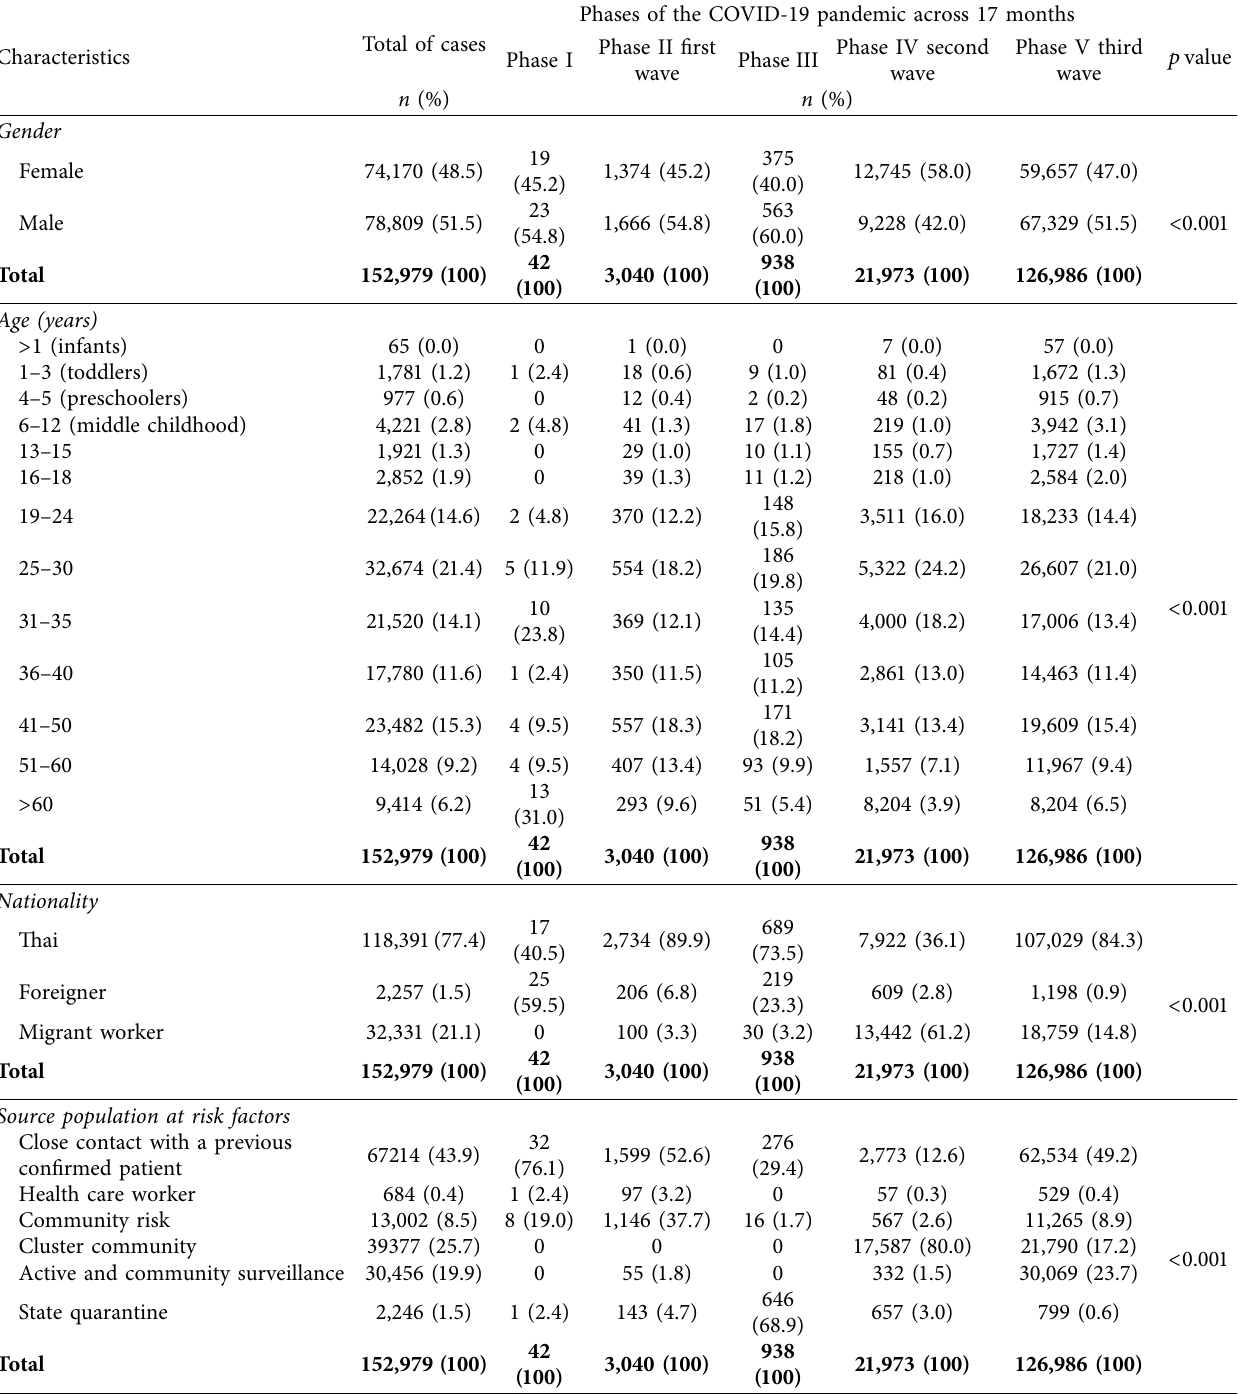
Table 2: Comparison of sociodemographic characteristics during different phases during COVID-19 pandemic in Thailand.